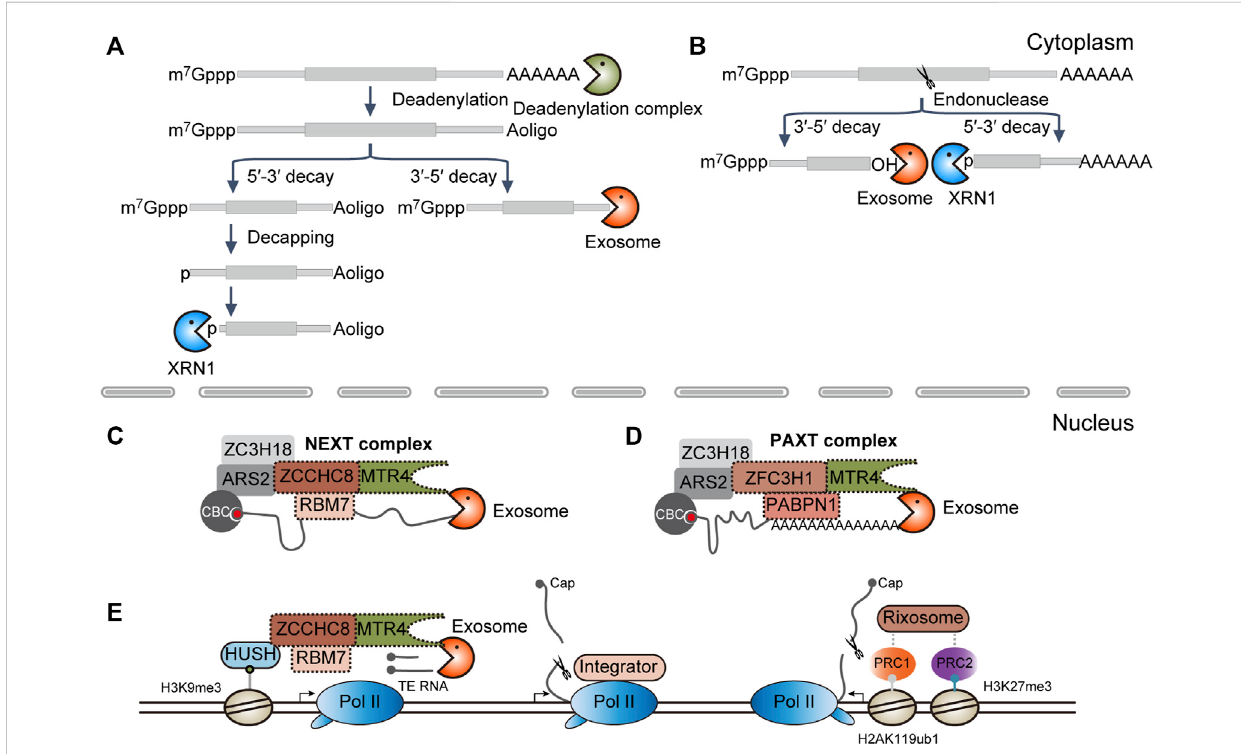
FIGURE 1 Diverse RNA decay pathways. (A) RNA exonucleolytic decay pathways in the cytoplasm. XRN1, 5 ′ -to-3 ′ RNA exonuclease; exosome, 3 ′ -to-5 ′ RNA exonuclease complex. (B) RNA endonucleolytic decay pathways in the cytoplasm. (C) NEXT complex-mediated RNA decay in the nucleus. CBC, cap- binding complex, composed of CBC20 and CBC80; NEXT, nuclear exosome targeting complex, composed of ZCCHC8, RBM7, and MTR4. (D) PAXT complex-mediated RNA decay in the nucleus. PAXT, PolyA tail exosome targeting complex, composed of ZFC3H1, PABPN1, and MTR4. (E) Co- transcriptional RNA decay pathways. Human silencing hub (HUSH) complex functions in the maintenance of the H3K9me3 modi fi cation. HUSH is composed of the chromodomain containing proteins MPP8, TASOR, and PPHLN1, in which MPP8 can interact directly with ZCCHC8, one subunit of the NEXT complex; Pol II, RNA polymerase II; Integrator is composed of 14 subunits, in which IntS11 along with IntS4 and 9 make up the endonucleolytic cleavage module. Integrator can directly bind to Pol II; PRC, Polycomb repressive complex; here, PRC1 and PRC2 can catalyze the mono-ubiquitination ofhistone H2Alysine 119(H2AK119ub1) andtri-methylation ofH3 lysine 27(H3K27me3),respectively. Rixosomeiscomposedof seven subunits, inwhich LAS1L is the endonucleolytic subunit, whereas the TEX10 subunit can interact with the PRC